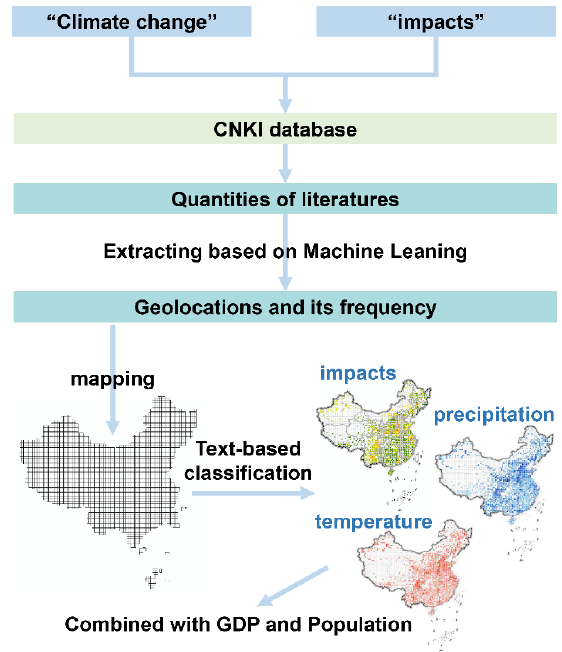
Figure 1. The overall framework of this study.